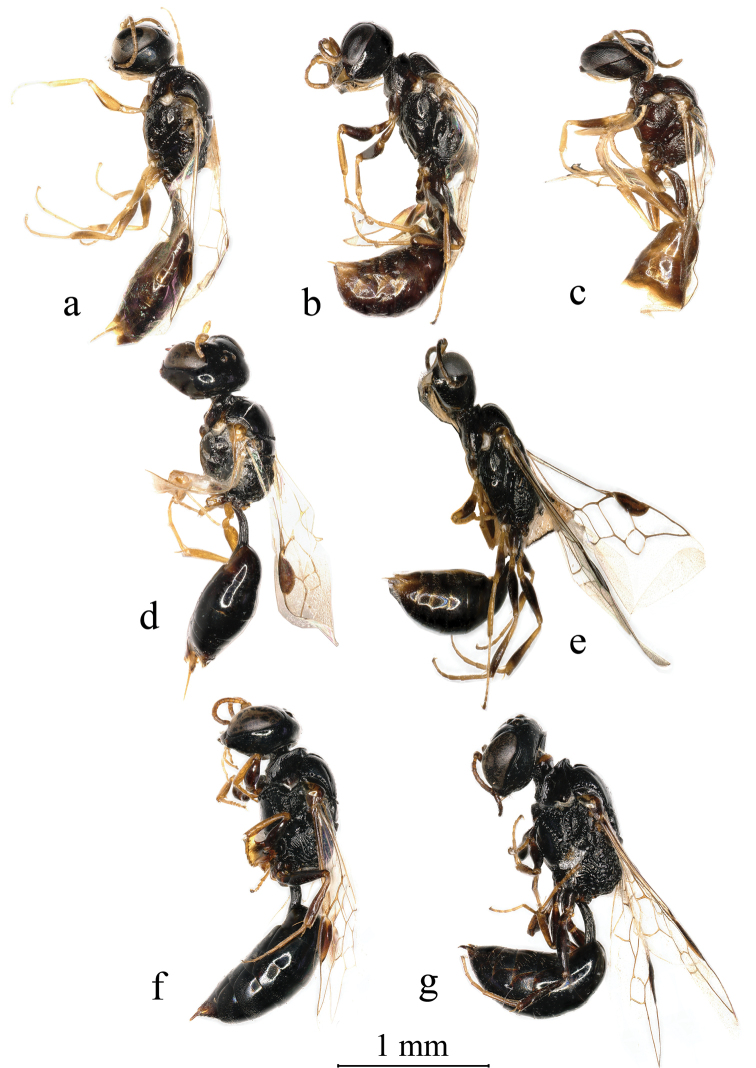
aStigmuscapoblongus Bashir & Ma, sp. n. (male) b, cStigmusdenticorneus Bashir & Ma, sp. n. (b female c male) dStigmusfronticoncavus Bashir & Ma, sp. n. (female) eStigmusinterruptus Bashir & Ma, sp. n. (female) f, gStigmuslobomelanicus Bashir & Ma, sp. n. (f female g male) a–g lateral view, Scale bars: 1 mm (a–g).